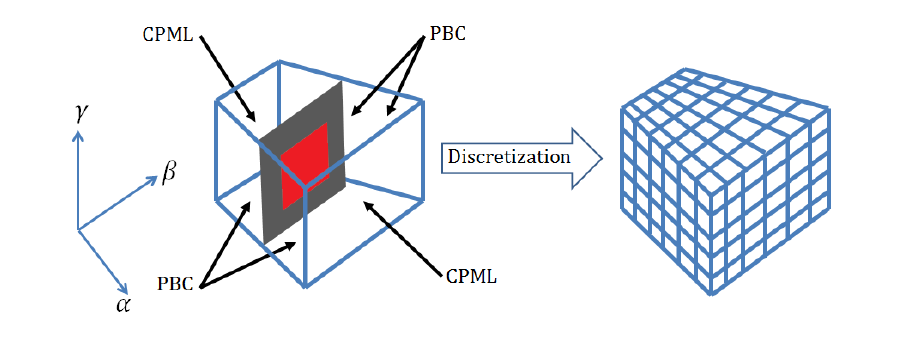
Figure 4. Unit cell for FDTD simulation for a faceted cylindrical array.